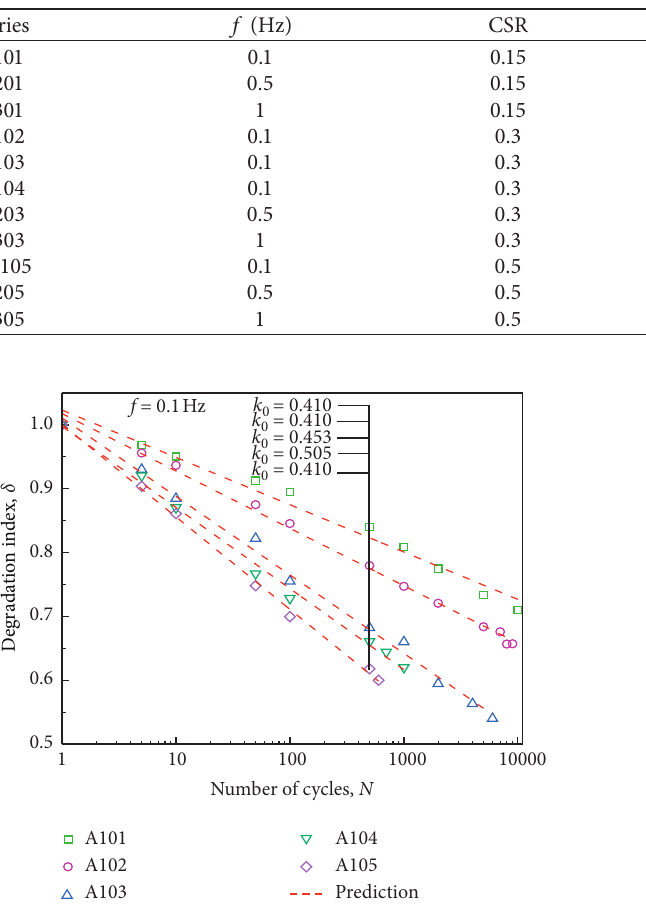
Figure 10: Comparison of the measured value and predicted value.